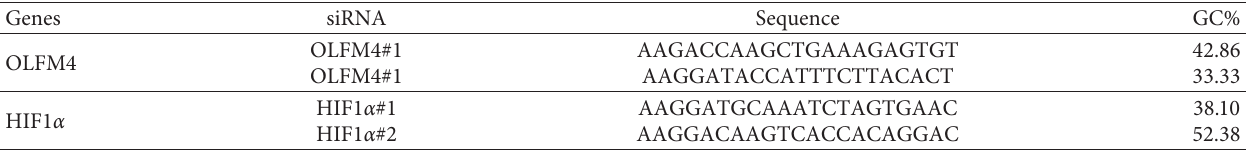
Table 2: Sequences of